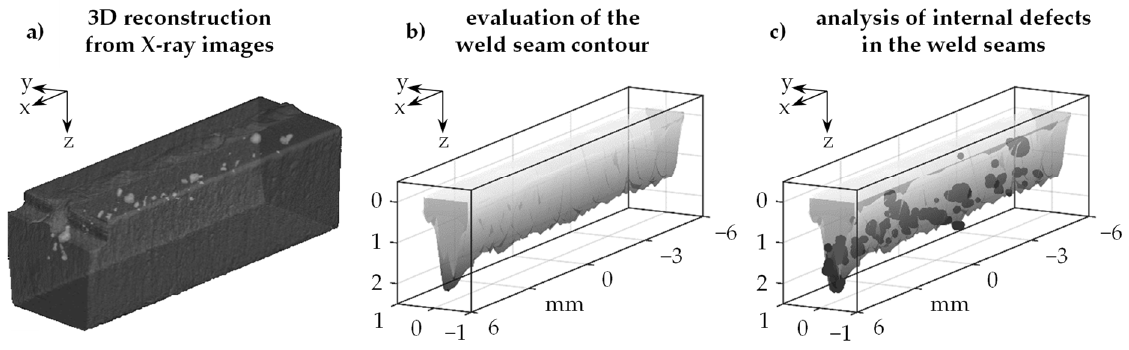
Figure 8. ( a ) 3D reconstruction of µ CT scans of a weld seam; ( b ) evaluation of the weld seam contour; ( c ) examination of the correlations between the weld seam contour and internal defects; material AA 2219, laser power 1.5 kW, feed rate 9 m/min.